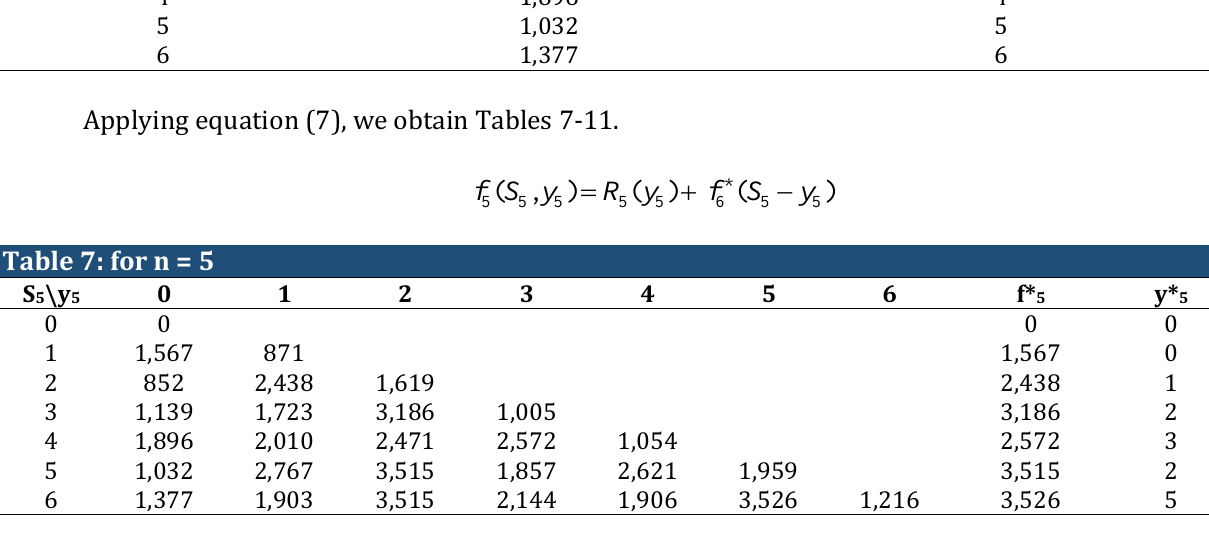
Table 6: for n = 6